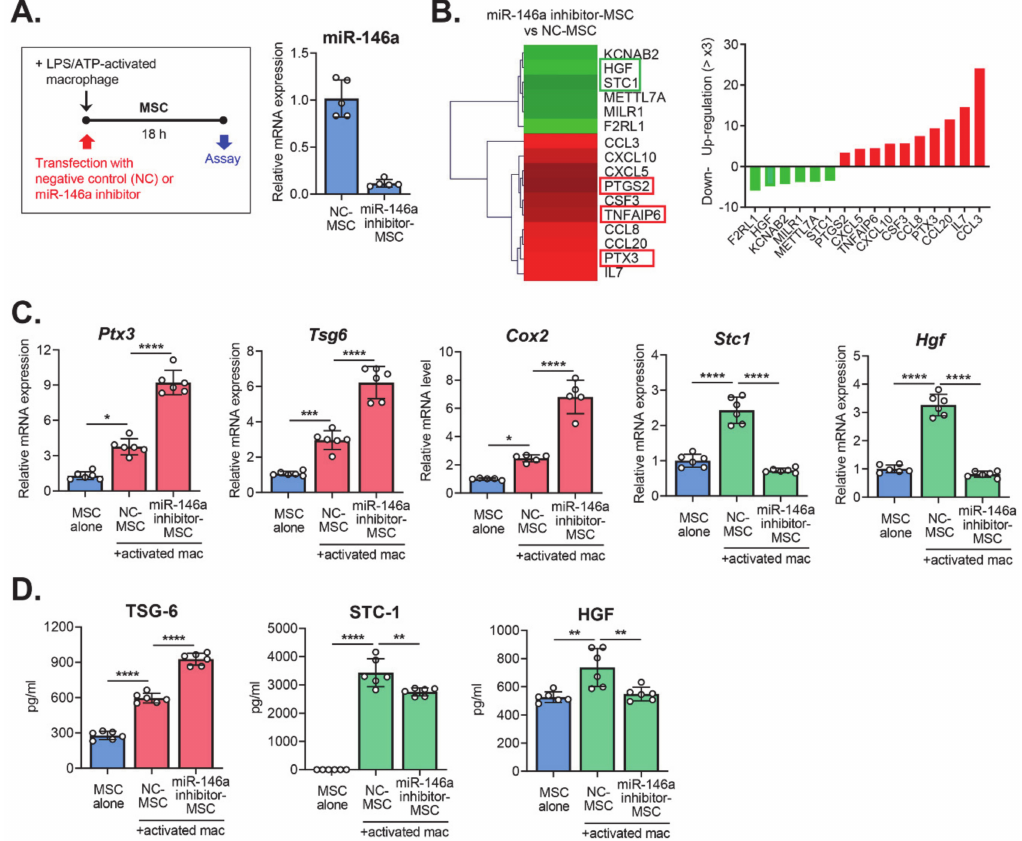
Figure 2. The changes in the expression of immunoregulatory molecules in MSCs after miR-146a knockdown. ( A ). Scheme for experiments. MSCs were transfected with a miR-146a inhibitor (miR-146a inhibitor-MSC) or a negative control (NC-MSC) and were co-cultured with LPS / ATP-activated macrophages for 18 hours. The knockdown of miR-146a in MSCs was confirmed by real-time RT-PCR. ( B ). A heat-map and list of immune response- and secretion-related genes based on RNA sequencing of miR-146a inhibitor-MSCs as compared with NC-MSCs. Shown are the genes whose expressions were up- or downregulated by > three-fold in miR-146a inhibitor-MSC relative to NC-MSC. ( C ). Real-time RT-PCR for immunoregulatory genes in MSCs. The mRNA levels of each gene in MSCs co-cultured with LPS / ATP-activated macrophages are shown as the relative values to those in MSCs cultured alone. ( D ). ELISA (enzyme-linked immunosorbent assay) for secreted protein levels of immunoregulatory molecules. * p < 0.05, ** p < 0.01, *** p < 0.001, and **** p < 0.0001, as analyzed by one-way ANOVA and Tukey’s multiple comparisons